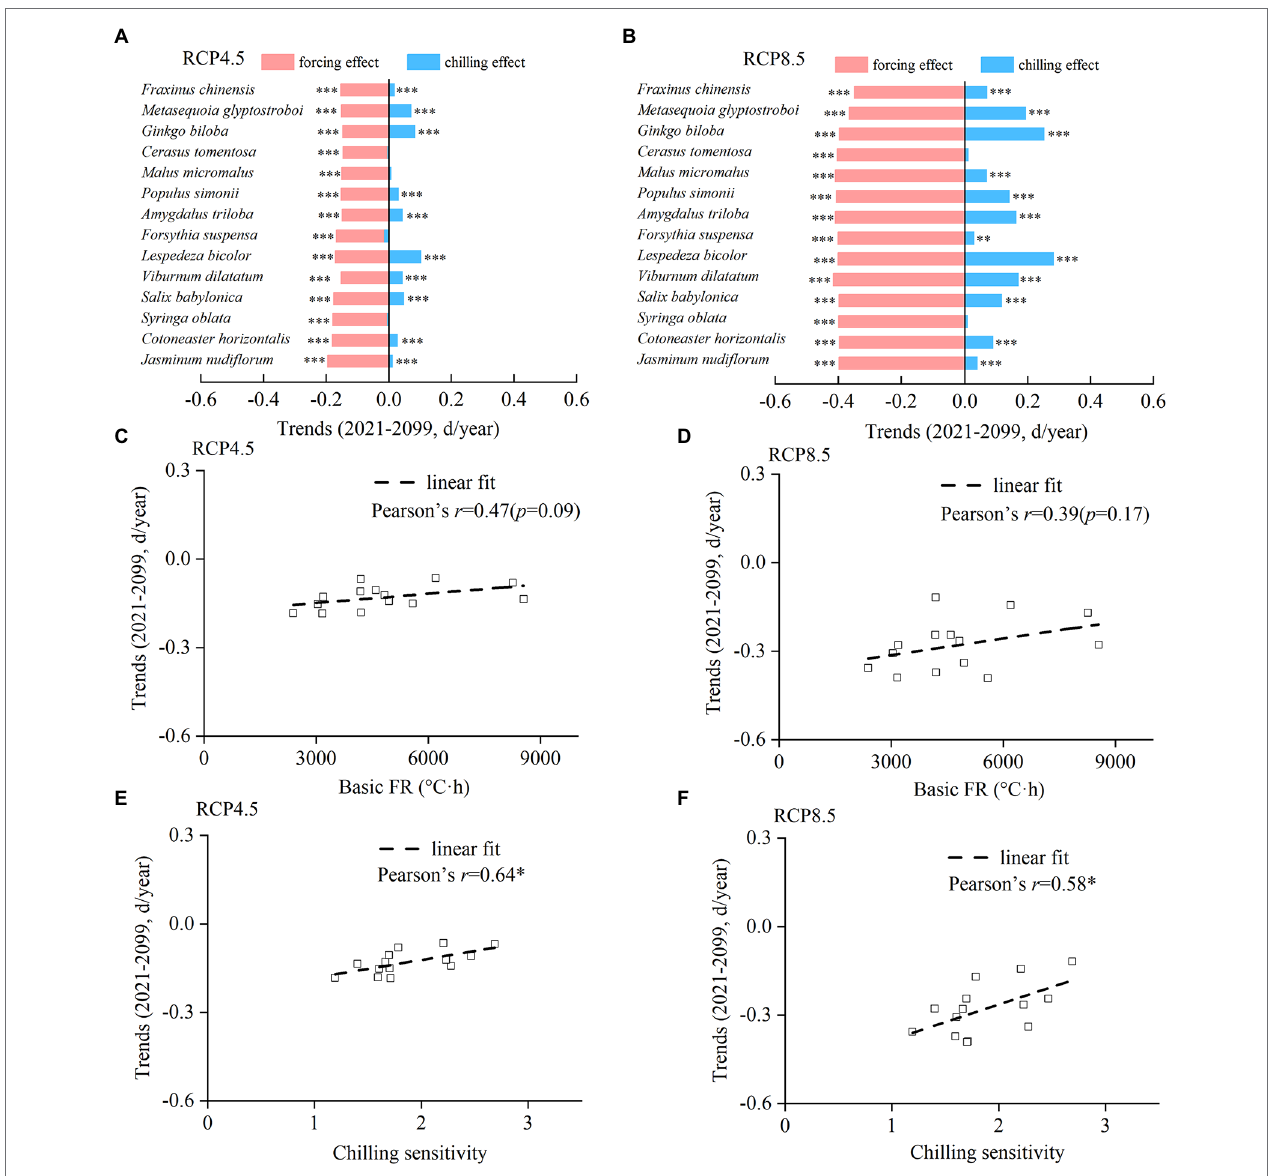
FIGURE 7 | Interspecific difference in trends of the chilling effect, forcing effect, and onset date of spring events from 2021 to 2099. (A,B) Trends of the chilling effect and forcing effect for each species under RCP 4.5 (A) and RCP 8.5 (B) . (C,D) The relationship between the trends of spring events and basic forcing requirement (basic FR). (E,F) Relationship between the trends of spring events and chilling sensitivity. *** p < 0.001; ** p < 0.01; * p <